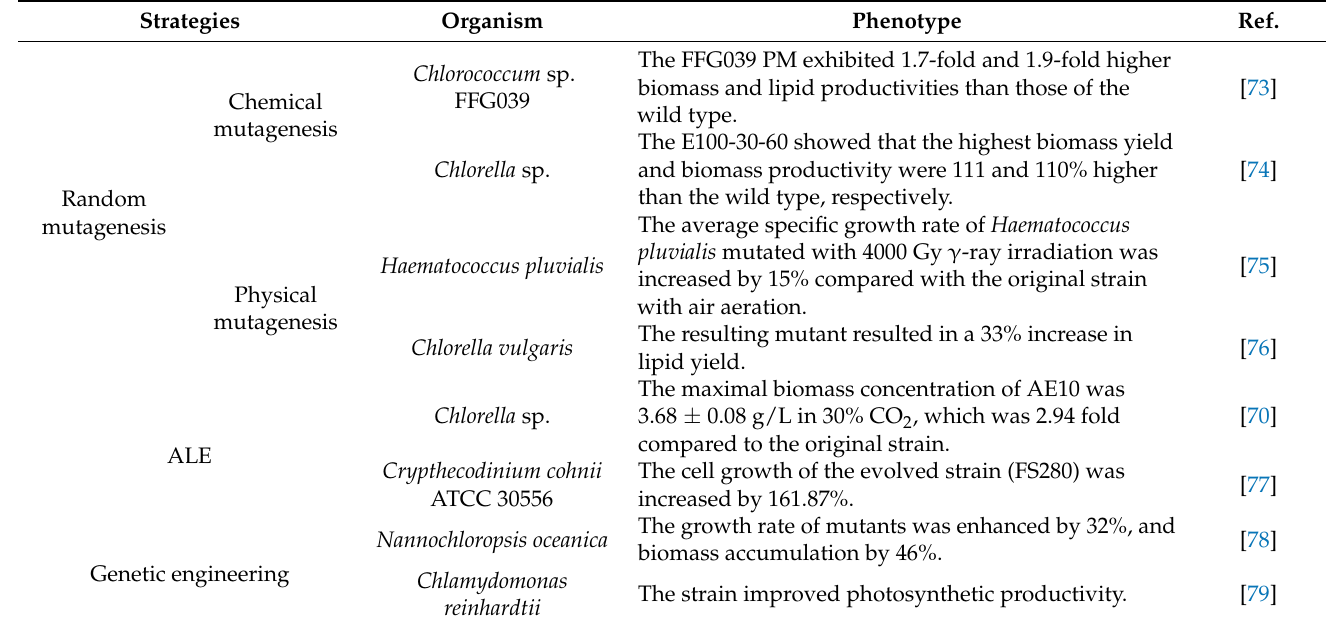
Table 3. Application of strategies to improve the photosynthetic efficiency of